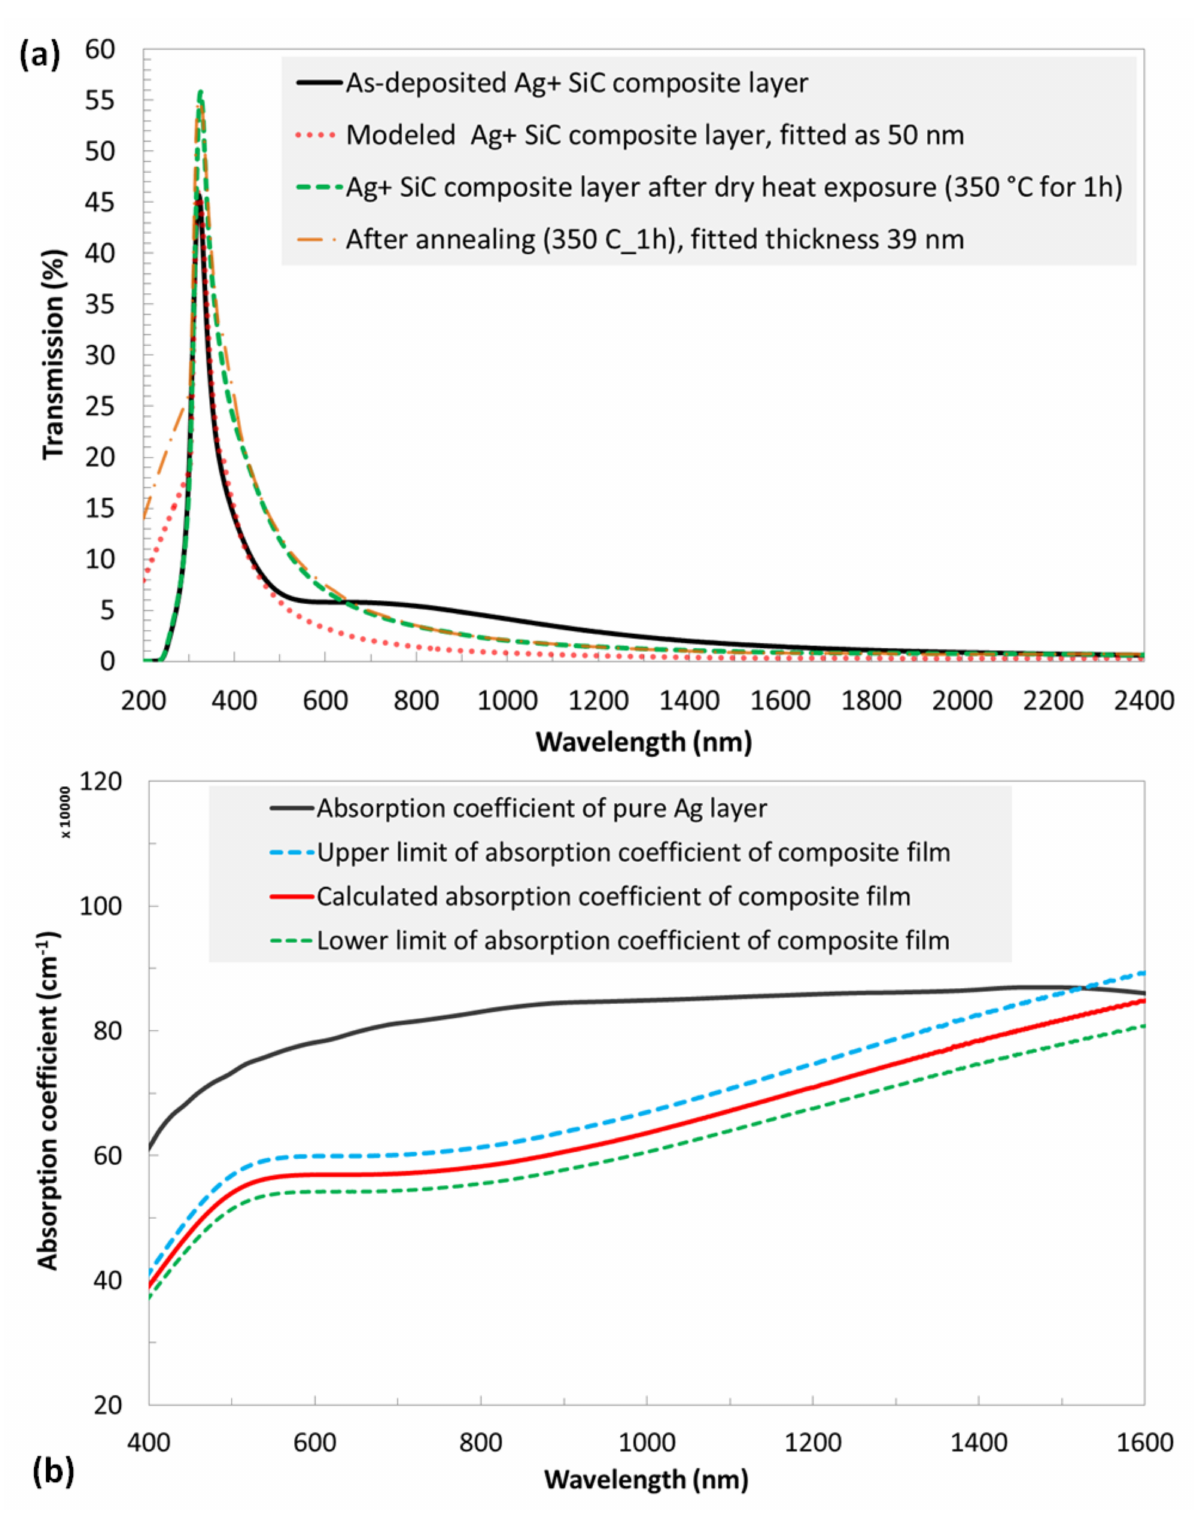
Figure 4. Optical characterization results were obtained from Ag+ SiC thin-film nanocomposite layers ( a ) transmission spectra and ( b ) optical absorption